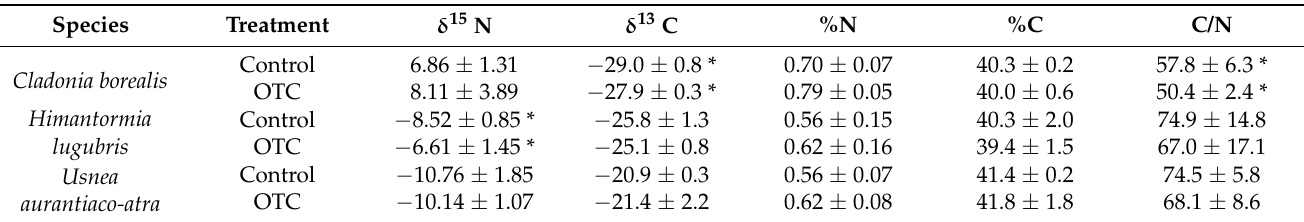
Table 2. Mean content ( ± standard deviation, n = 3) of stable isotopes ( δ 15N and δ 13C), relative content (%N and %C), and carbon-to-nitrogen ratio (C/N) of different Antarctic lichen species subjected to in situ passive warming (OTC) and under natural conditions (control). Asterisks show significant differences ( p <